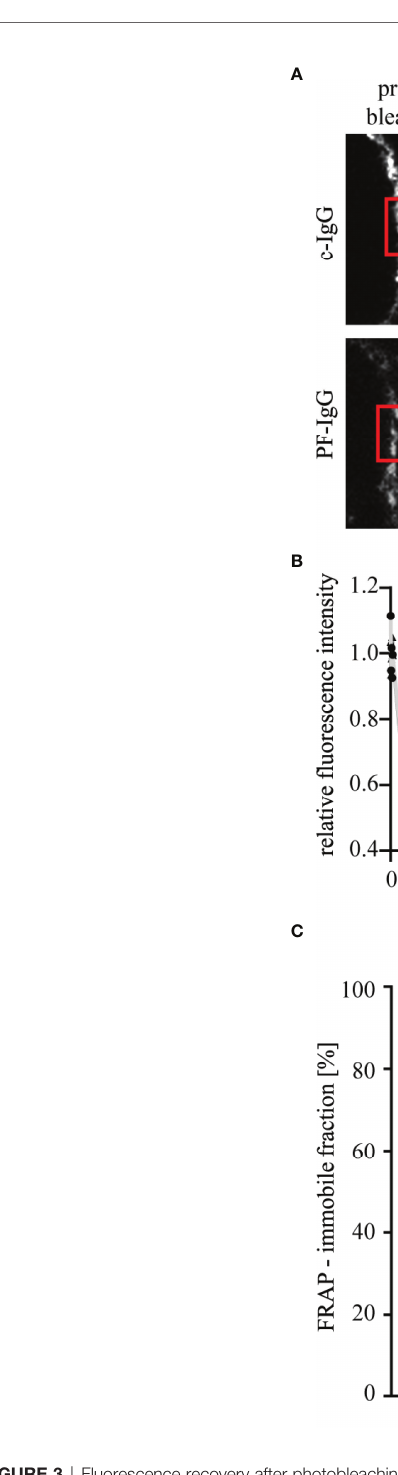
FIGURE 3 | Fluorescence recovery after photobleaching of Dsg1-mCherry is impaired after incubation with PF-IgG but can be rescued by blocking of PLC or Ca 2+ signaling. (A) Representative images of fl uorescence recovery after photobleaching (FRAP) time series. Cells were incubated for 24 h with IgG fractions and mediators. A part of the cell membrane between two neighboring cells is recorded, then the area marked with the red box is bleached with the laser as apparent by the drop in fl uorescent intensity and the recovery of the fl uorescence is monitored over 3 minutes. Scale bar: 5µm. (B) Corresponding fl uorescence intensity recovery curves to (A) ; normalized to pre-bleach intensity. (C) Quanti fi cation of the average fraction of immobile Dsg1-mCherry molecules as calculated from fi ts to fl uorescence recovery curves. N ≥ 3; each dot represents the mean of ≥ 3 FRAP experiments in ≥ 3 different cell pairs of one independent experiment. *P < 0.05 in two-way ANOVA; error bars represent standard